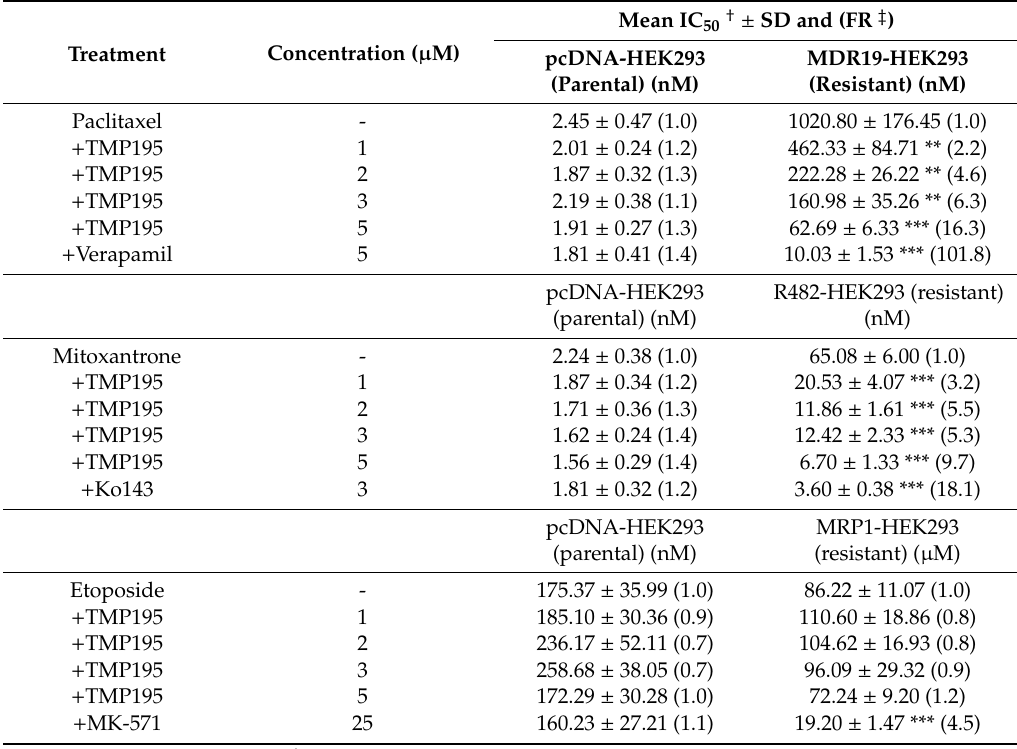
Table 1. E ff ect of TMP195 on drug resistance mediated by major ATP-binding cassette (ABC) drug e ffl ux transporters in HEK293 cells transfected with ABCB1, ABCC1 or ABCG2.